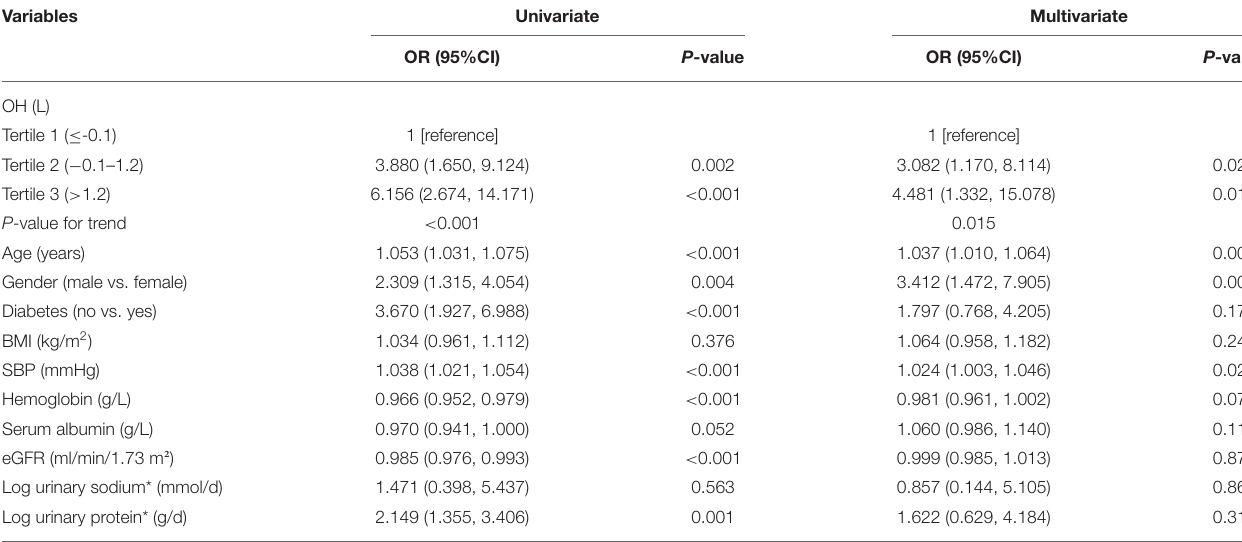
TABLE 3 | Univariate and multivariate logistic regression for the association between OH and LVH in all the enrolled patients with CKD. Variables Univariate